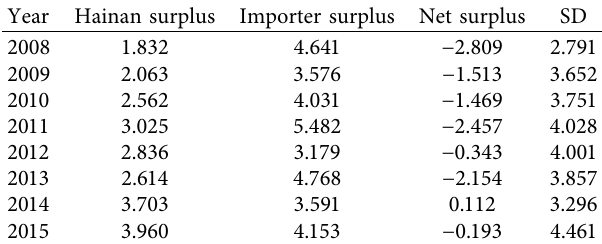
Table 9: Annual surplus distribution characteristics of exporters and